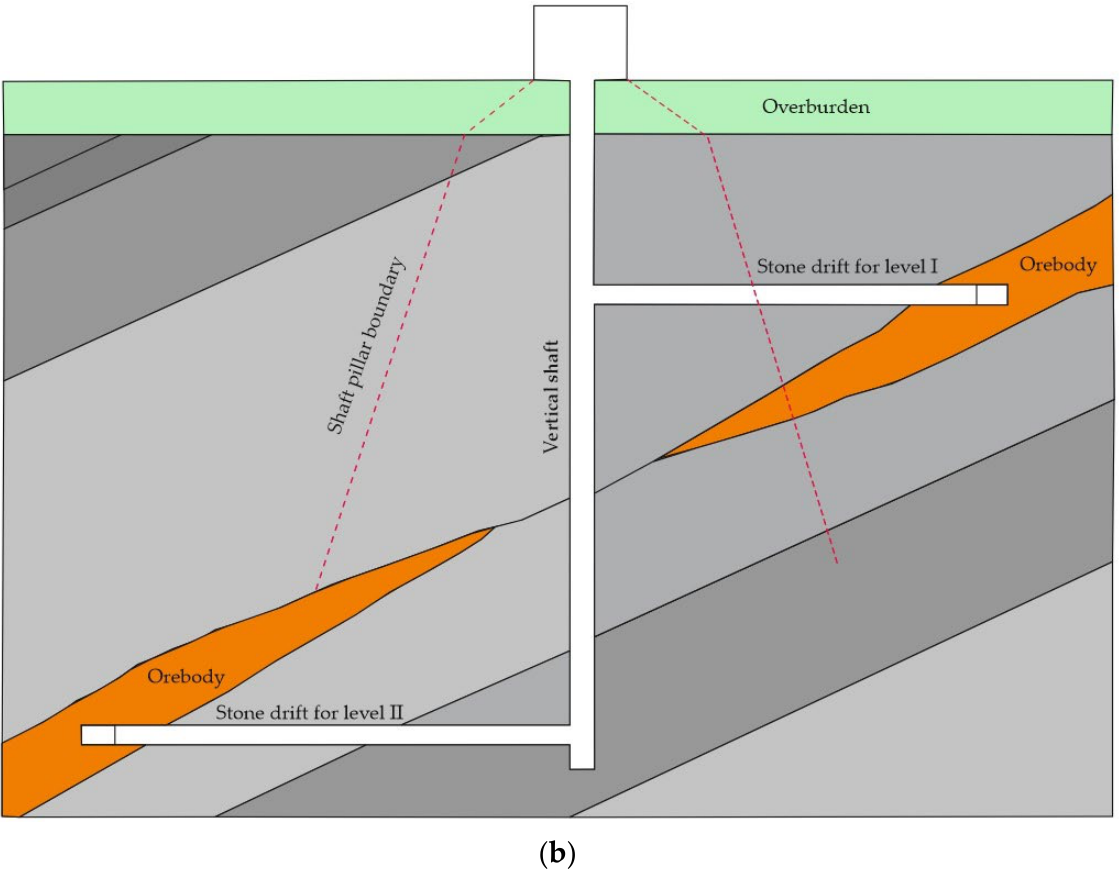
Figure 4. Access by means of vertical shaft: ( a ) With stone drifts; ( b ) Located in the place of thinning out; A,B,C,D—points in the rock mass from which the sections for the roof, deposit and floor are marked. A vertical shaft with stone drifts is the most appropriate and most frequently used method of making available several decks or steeply lying veins, as well as nest beds consisting of one or more sockets [21]. If the nests are located at different depths, it is necessary to drive shafts from stone drifts. The small shafts should be driven from the lower level to the higher nest, so that the output can be transported. Transporting the output to a higher level is associated with higher costs and then the transport capacity of the small shaft is lower. Therefore, the output is only hoisted when the nest lies below the deepest mining level of the mine. To avoid or reduce losses in the protective pillar, the shafts should be located between the sockets or on the side of the deposit. The advantages of vertical shafts